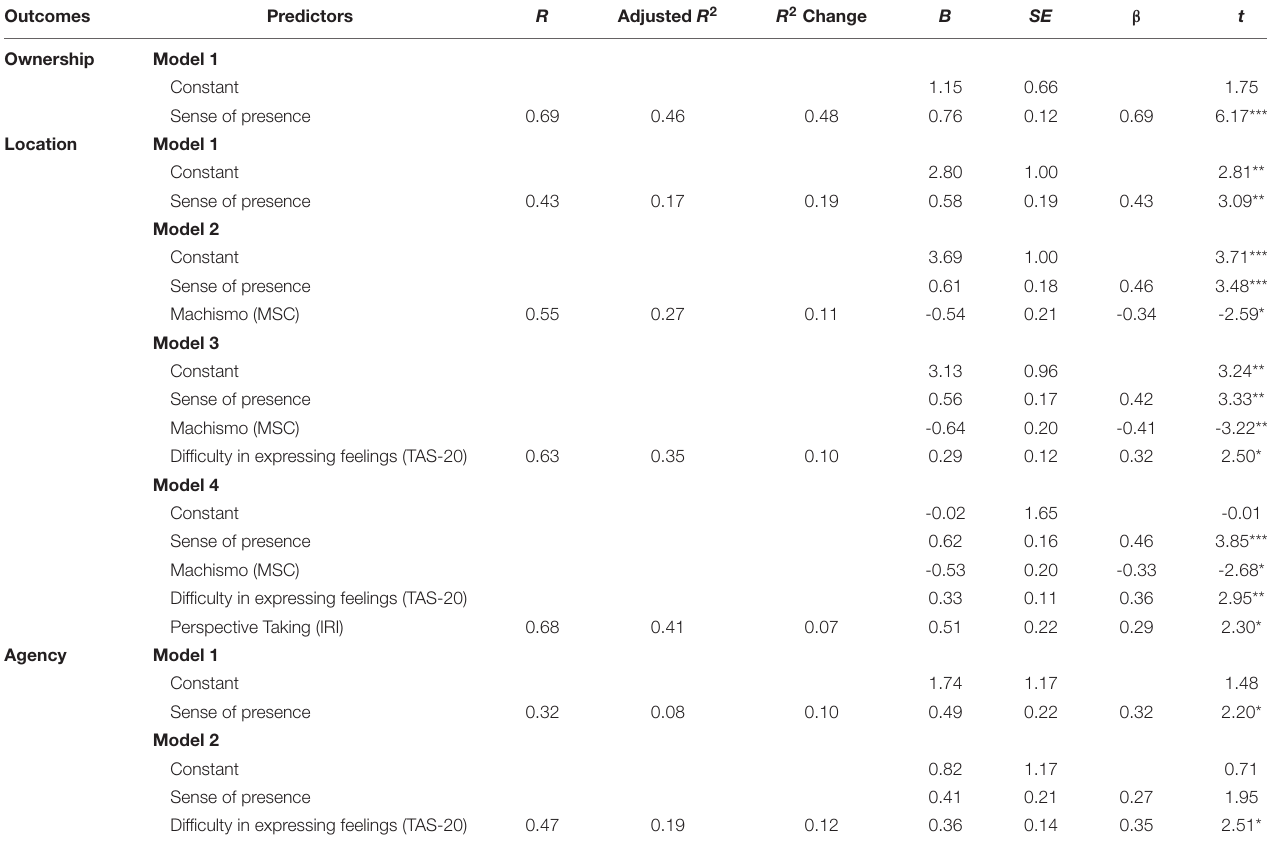
TABLE 3 | Stepwise multiple regressions of embodiment scores.